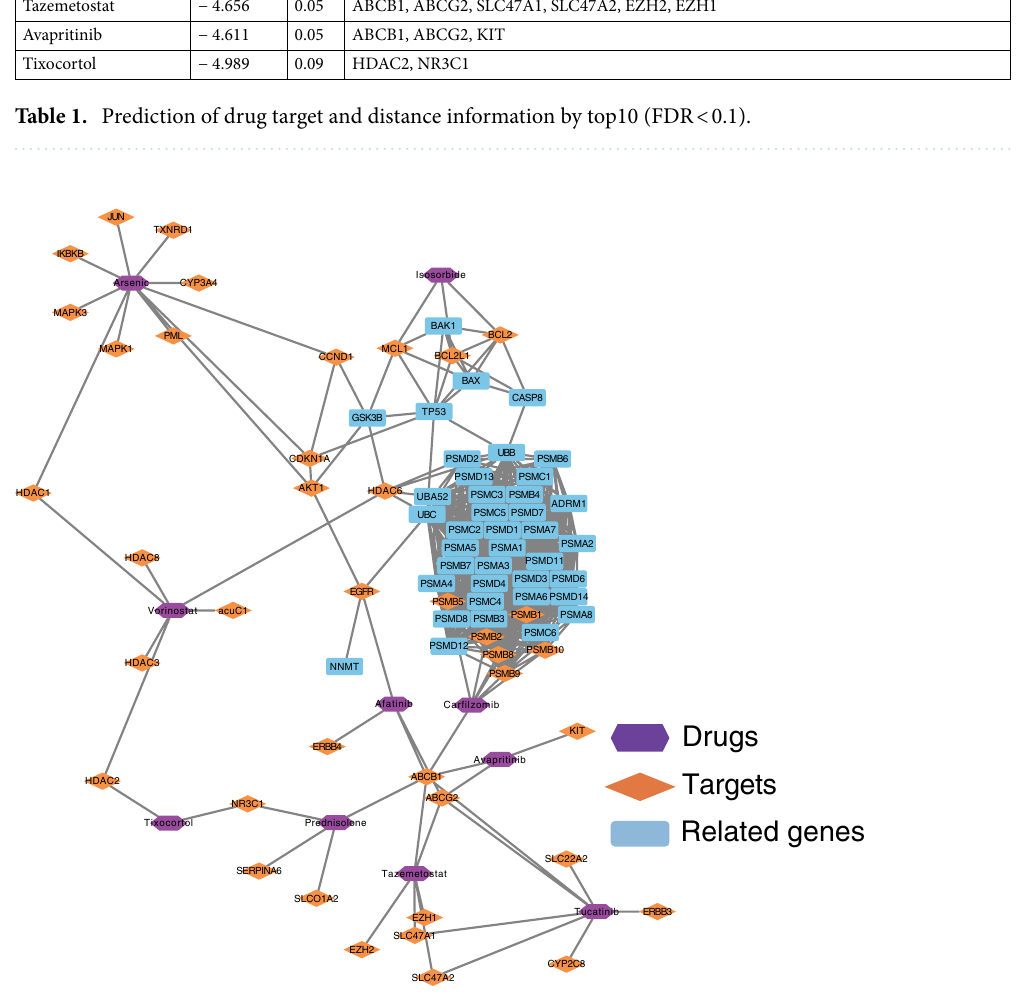
Figure 5. Building and analysis of drug-target-gene network. Purple nodes represent drug candidates, orange diamonds represent drug targets, and blue rectangles represent PD-related genes. Visualization tool: Cytoscape (3.7.2). https:// cytos cape.